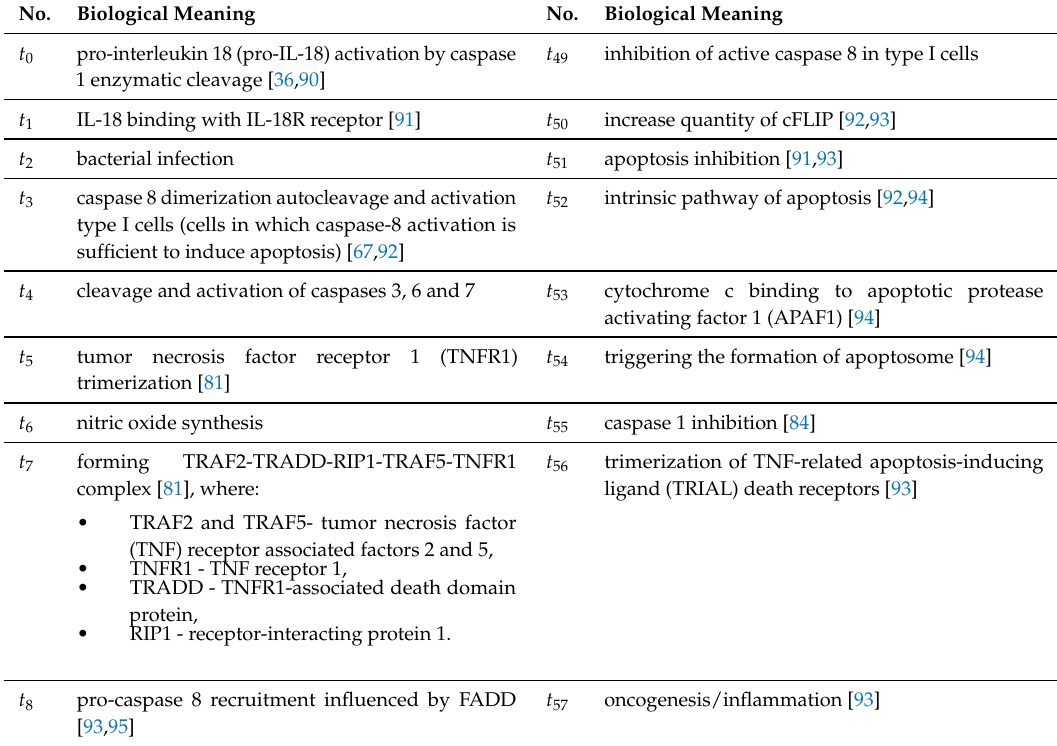
Table A2. List of transitions. The column “No.” includes the names of transitions and the column “Biological meaning” includes the names of biological functions of